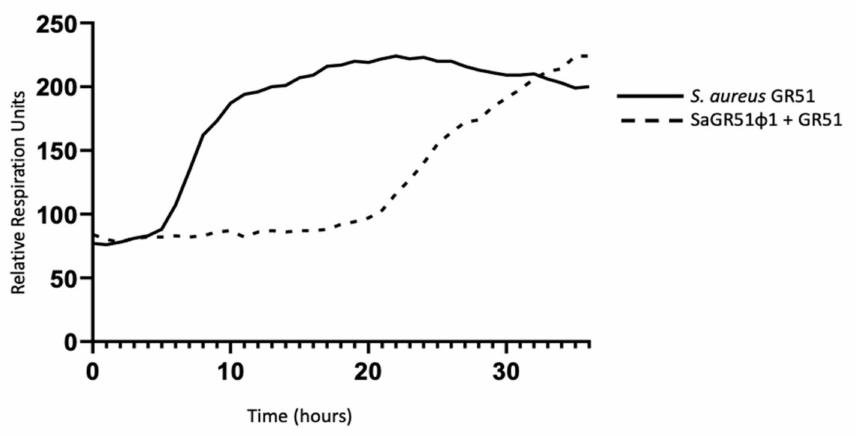
Figure 3. Time-kill curve using the Biolog assay demonstrating in vitro lysis of the patient’s bacterial isolate (GR51) by phage SaGR51ø1. This was conducted in a micro-well plate, and colonies were not recovered and tested for resistance to the phage.